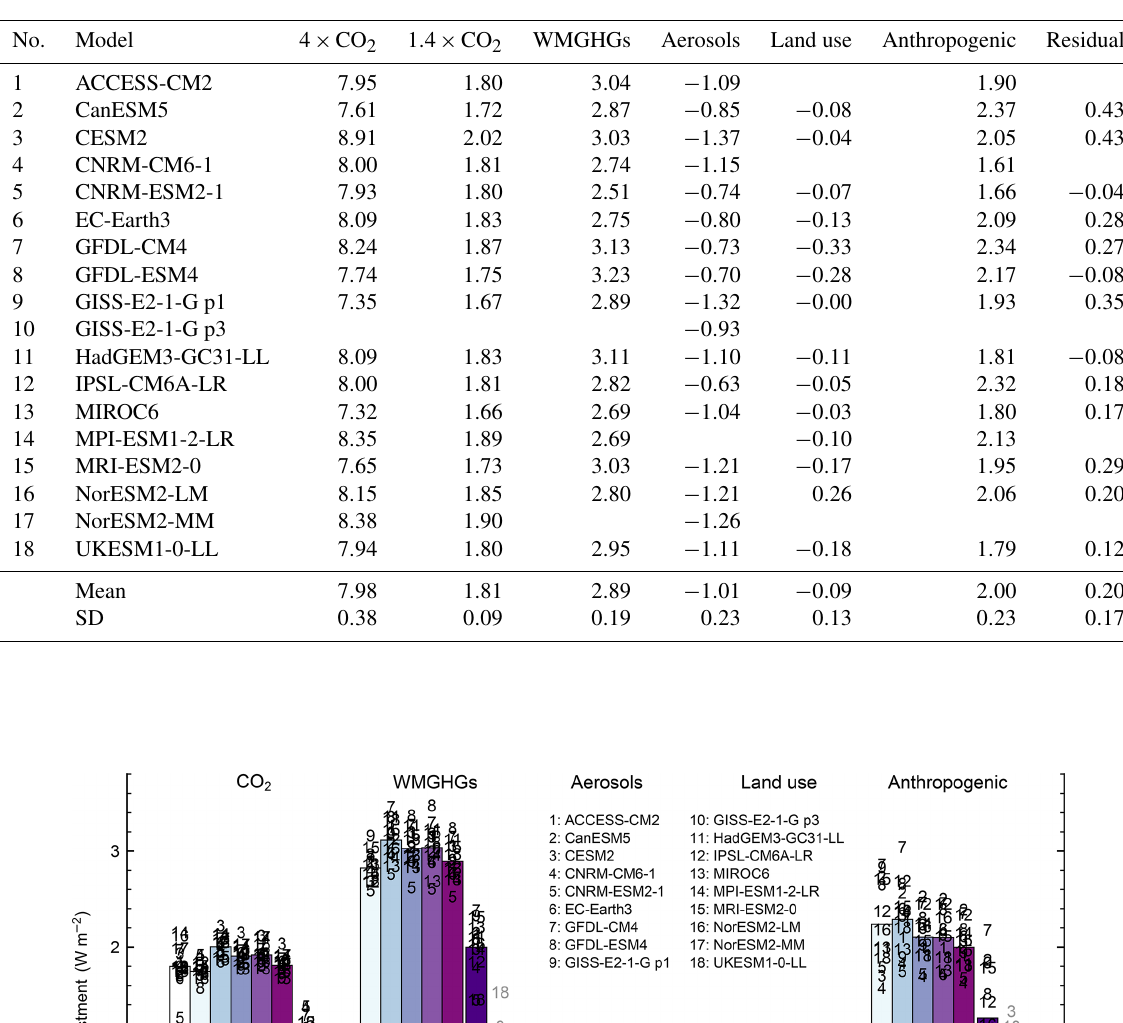
Table 2. Effective radiative forcing from each Tier 1 time-slice RFMIP experiment for each model (Wm − 2 ). Also shown is the 4 × CO 2 ERF scaled to 2014 concentrations (as 1 . 4 × CO 2 ) and the residual forcing (anthropogenic, WMGHGs, aerosol and land use). WMGHGs: well-mixed greenhouse gases. Note that not all models performed all experiments.